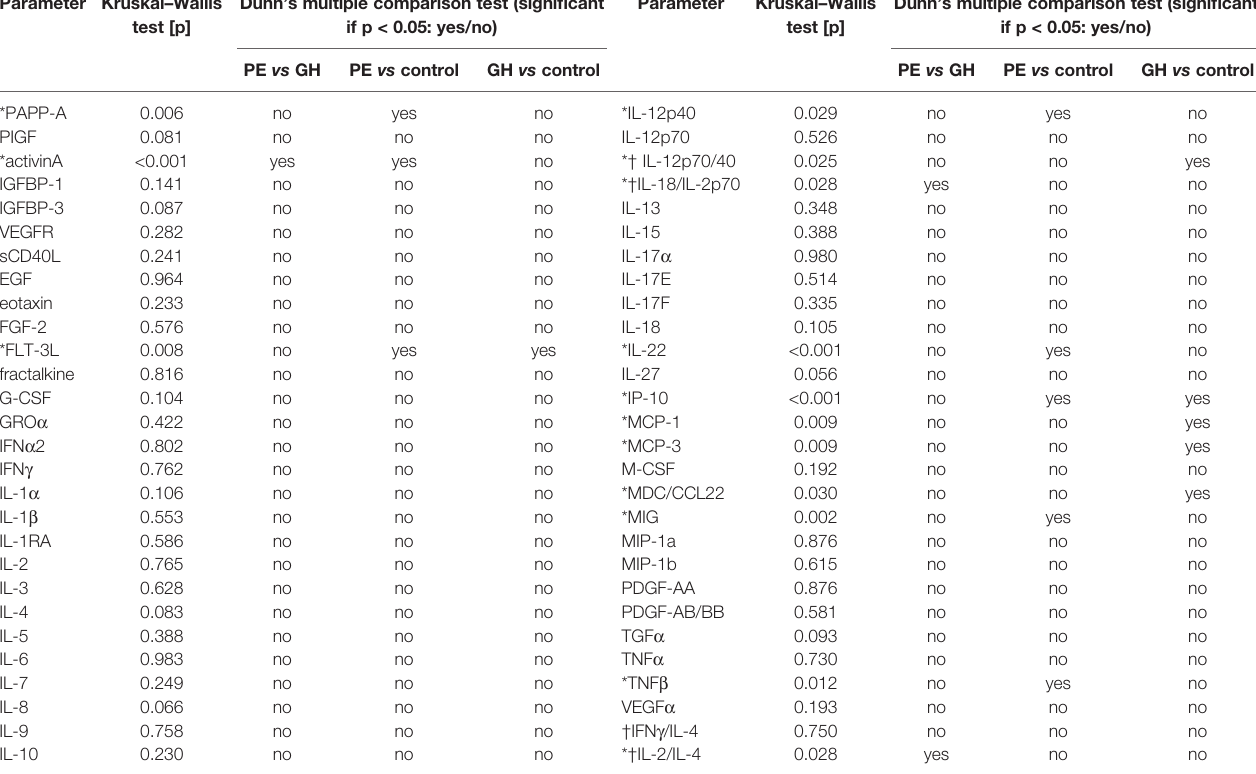
TABLE 2 | Screening for PE/GH markers. Parameter Kruskal – Wallis test [p]